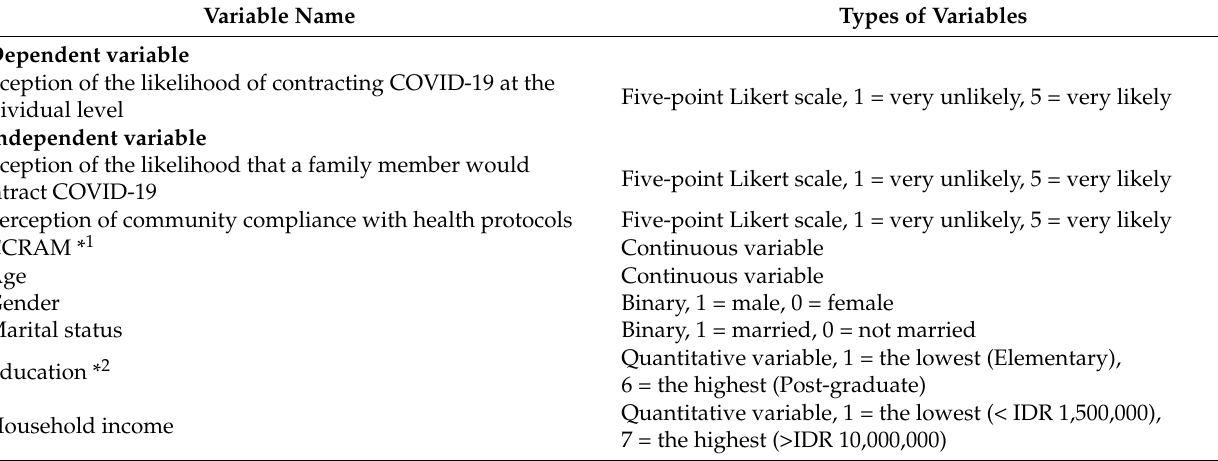
Table 1. Types of the dependent and independent variables.